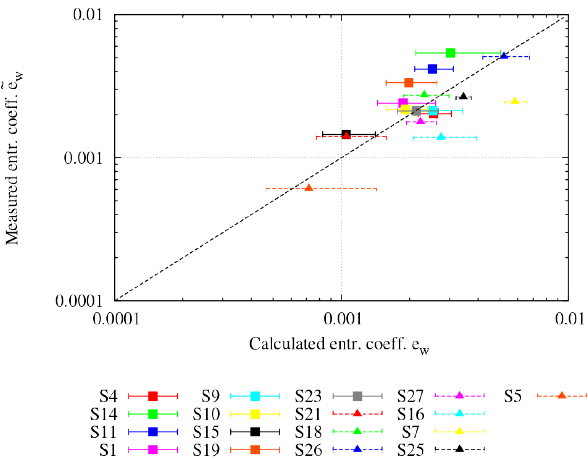
Figure 7. Experiment S4: spatial development of the mean velocity, mean height and flow discharge of the current, compared with their initial value. Figure 8. Comparison between the experimental value of the en-